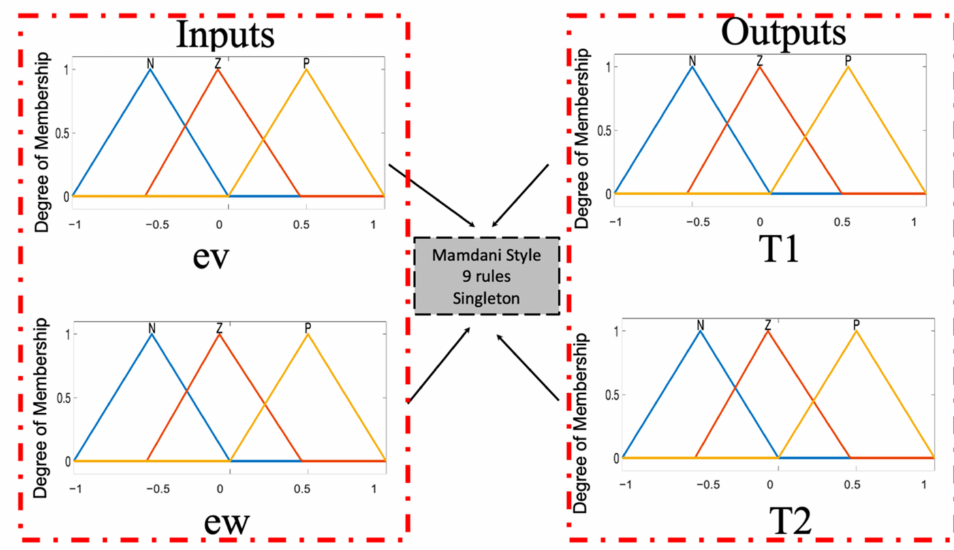
Figure 14. General idea of the Case Study.